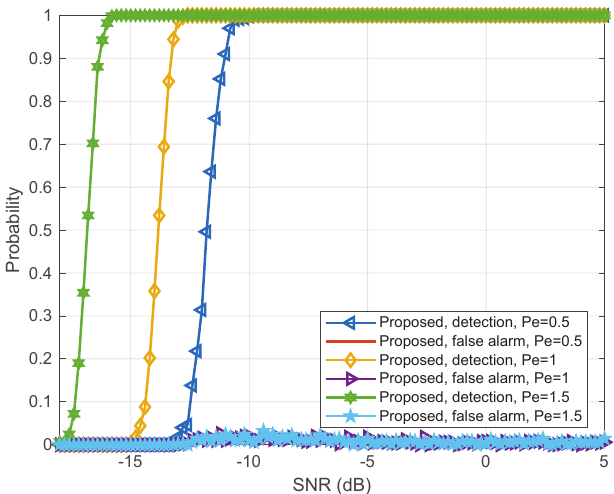
Figure 7. Effect of eavesdropper’s signal andlegitimate user’s signal power on detection performance = 10, M = 256 and K = when p b = 1, T M